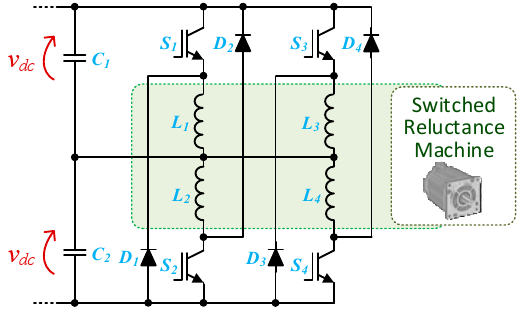
Figure 20. Split-capacitor power converter for switched reluctance machines.